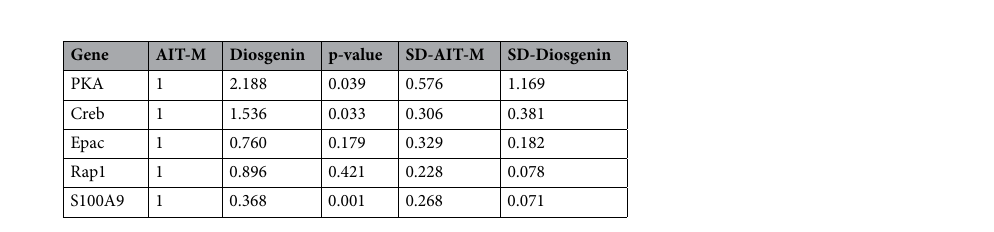
Table 3. Comparison of PKA, Creb, Epac, Rap1 and S100A9 mRNA expression in thyroid tissue ( ¯ x ± SD , n =